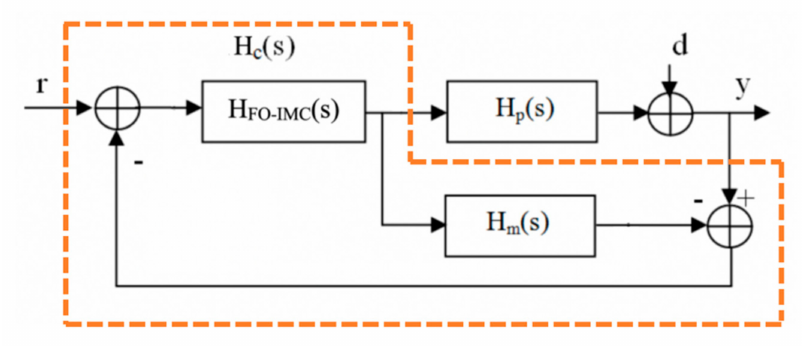
Figure 1. FO-IMC closed loop control